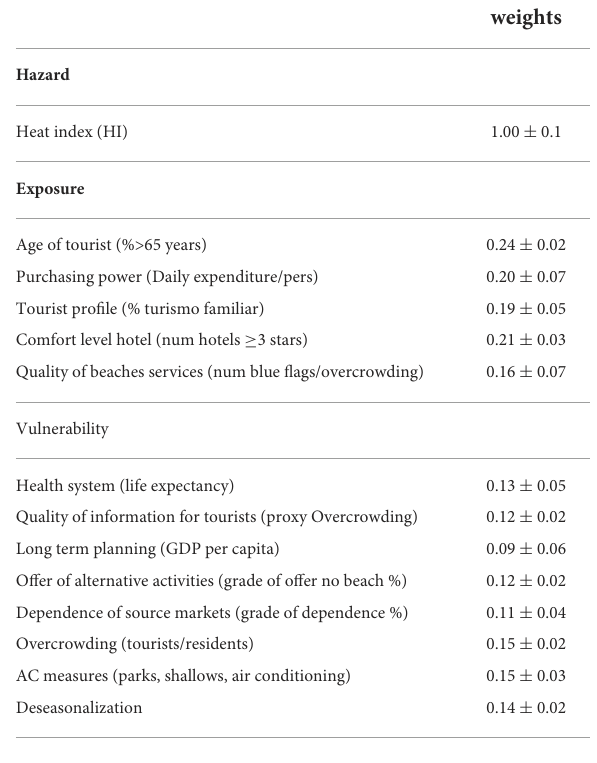
TABLE 4 Normalized values of the relative weights among the three risk components (i.e., hazard, exposure, and vulnerability) and their corresponding uncertainty, obtained from the AHP